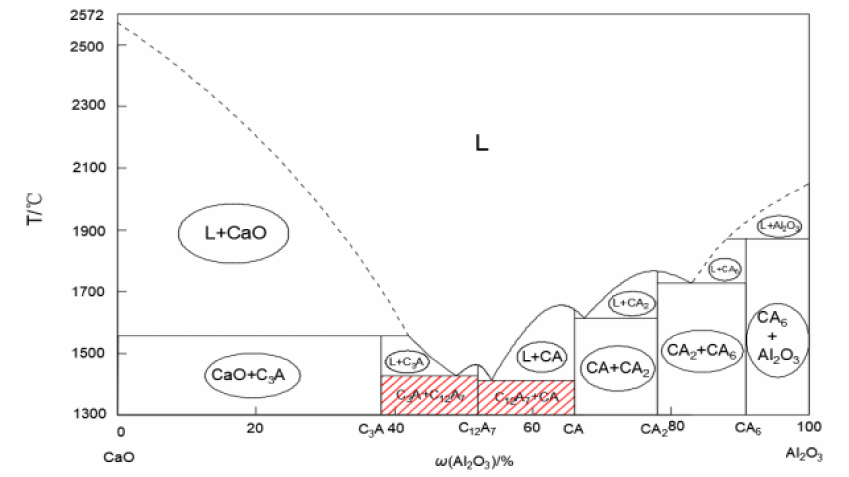
Figure 7. A phase diagram of the Al 2 O 3 -CaO binary system.